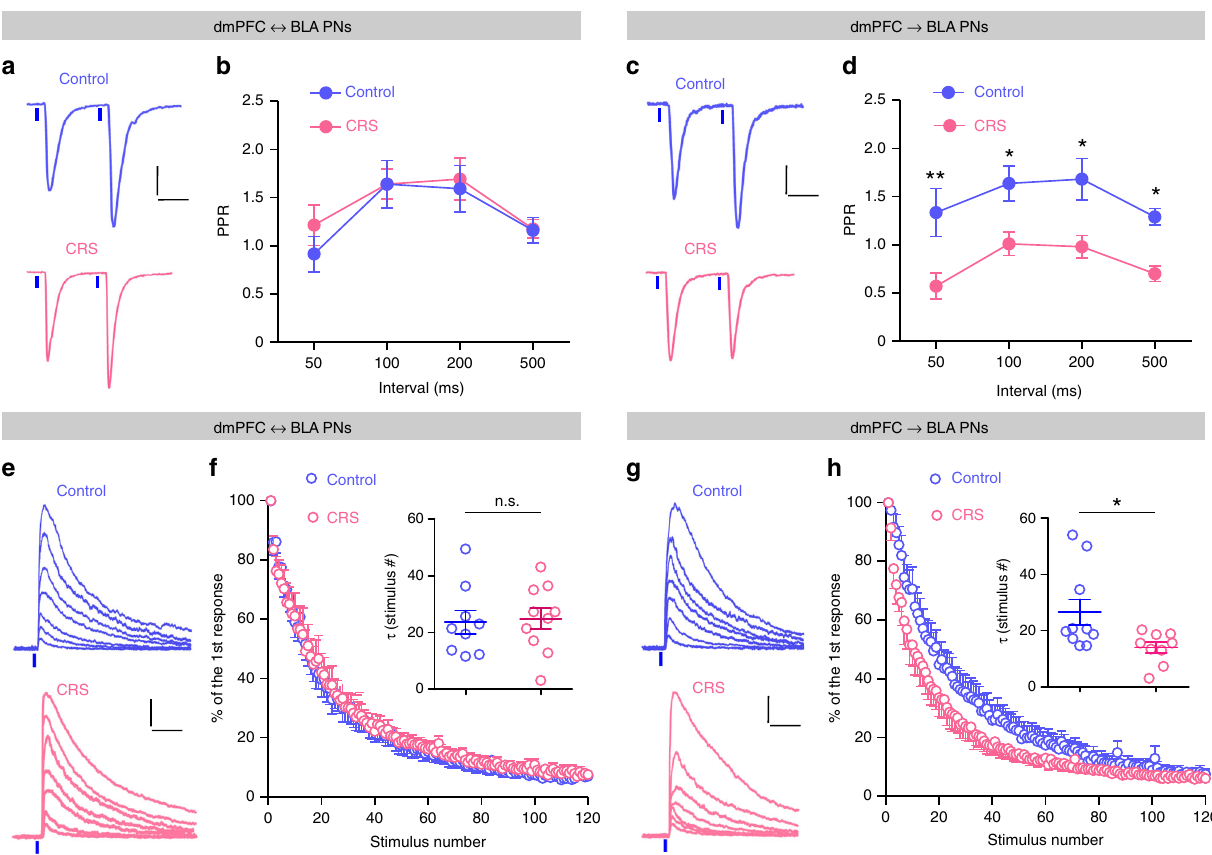
Fig. 3 Chronic stress selectively increases prefrontal cortical glutamate release onto dmPFC → BLA PNs. a Representative traces showing EPSCs in dmPFC ↔ BLA PNs upon paired light stimuli of dmPFC inputs (separated by 100 ms). Scale bar = 50 ms, 50 pA. b Summary plots of paired pulse ratio (PPR) in dmPFC ↔ BLA PNs. Control, n = 13 neurons/5 mice; CRS, n = 14 neurons/5 mice. c Same as in a except that the data were from dmPFC → BLA PNs. Scale bar = 50 ms, 50 pA. d Summary plots of PPR in dmPFC → BLA PNs. Control, n = 14 neurons/5 mice; CRS, n = 13 neurons/5 mice. e Representative traces showing the NMDA current in dmPFC ↔ BLA PNs in response to the 1st, 10th, 20th, 40th, 60th, 90th, and 120th photostimulation during MK-801 perfusion. Scale bar = 50 ms, 100 pA. f The progressive blockade of NMDA currents by MK-801 during light activation of dmPFC inputs. Each point represented averaged currents normalized to the fi rst one. Inset showing comparison of the averaged τ values. Control, n = 9 neurons/4 mice; CRS, n = 10 neurons/4 mice. g Same as in e except that the data were from dmPFC → BLA PNs. Scale bar = 50 ms, 100 pA. h Same as in f except that the data were from Table 1. n.s., not signi fi cant; * p < 0.05, ** p < 0.01. Source data are provided as a Source Data fi